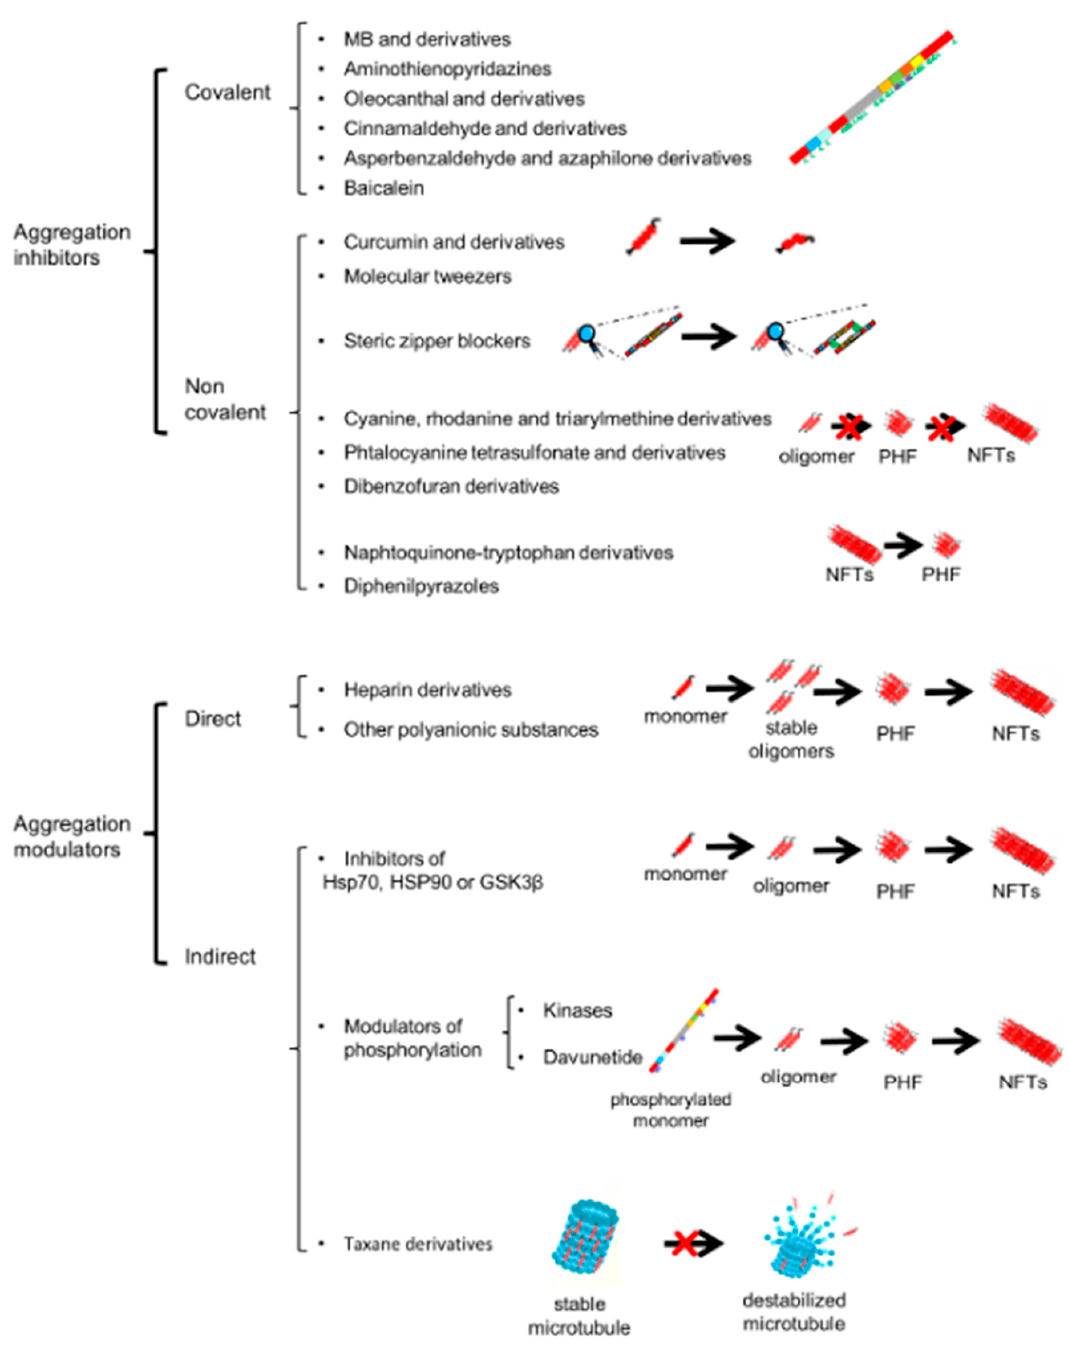
Figure 3. Schematic representation of the main compound groups mentioned in the text and their corresponding main mechanisms of action. Main interaction sites with the protein for covalent inhibitors and steric zipper blockers are shown in green. Tyrosines susceptible of phosphorylation by tyrosine kinases are show in